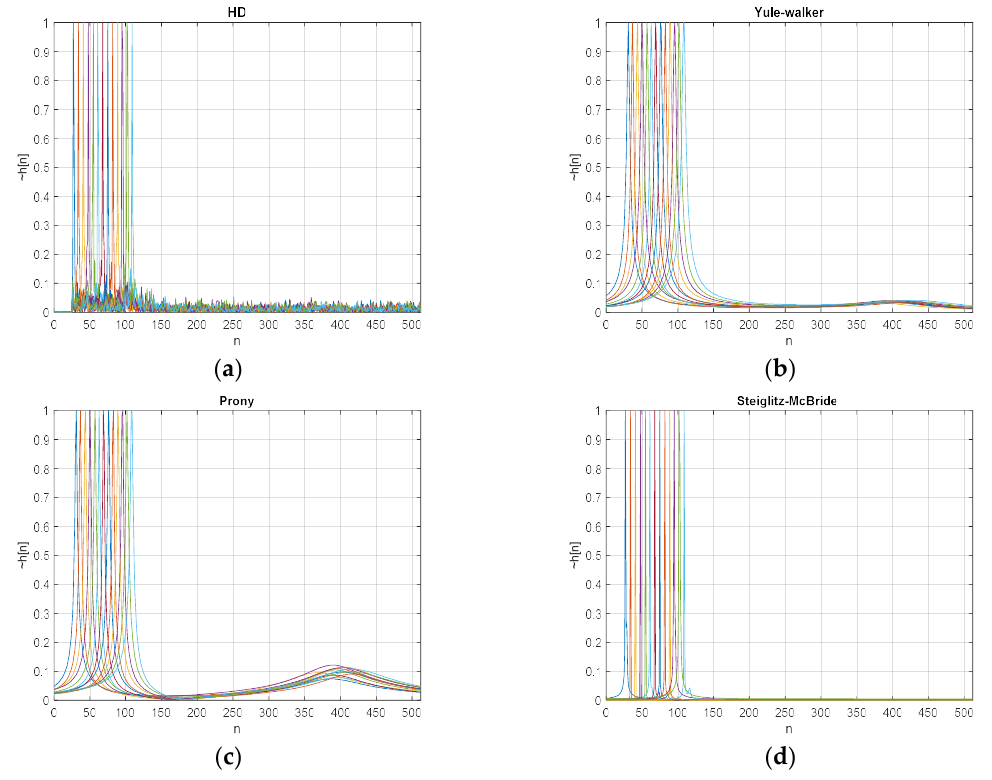
Figure 18. Estimated ℎ (cid:3560) [𝑛] distribution (normalized) with 100 ensemble average for ToF (20~80 cm in 10 cm interval) from: ( a ) non-parametric HD; ( b ) Yule-walker HD; ( c ) Prony HD; ( d ) Steiglitz-McBride HD.